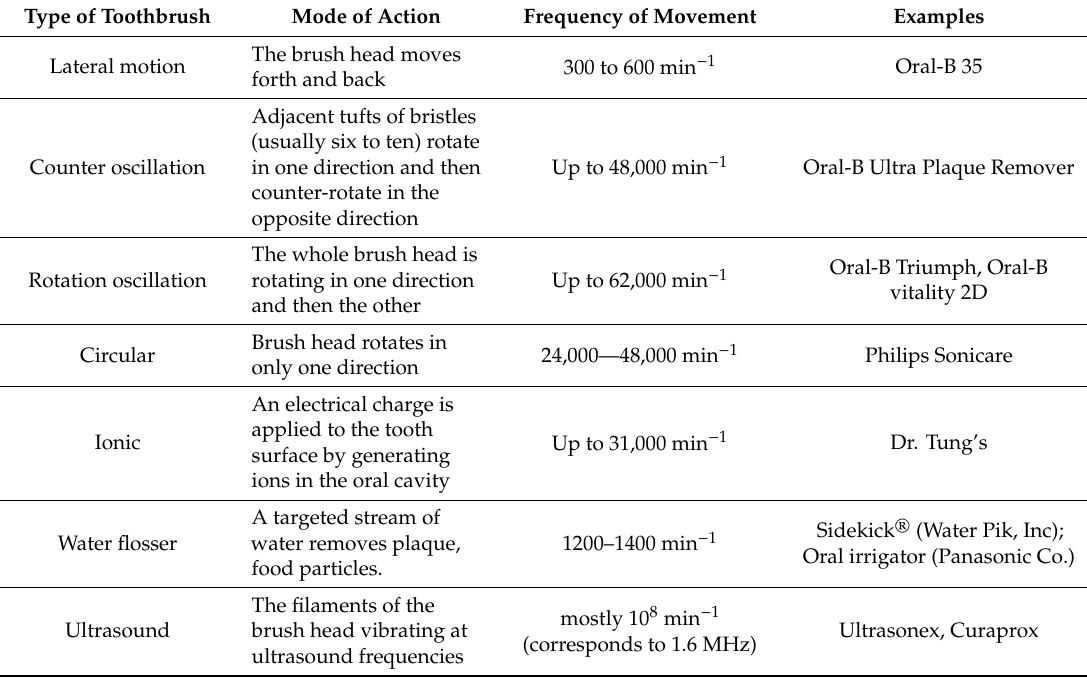
Table 1. Di ff erent types of powered toothbrushes and their working